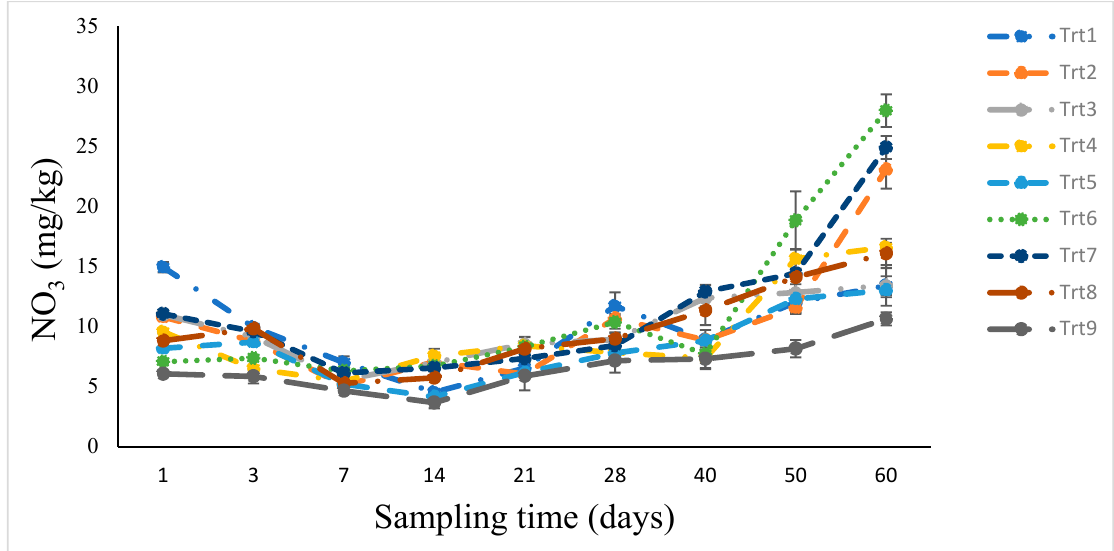
Figure 6. Nitrate released in soils during incubation at different rates of compost application. Key: Table 1. 3:1 − IMO at 5 t ha − 1 , Trt2: 3:1 − IMO at 10 t ha − 1 , Trt3: 1:2 − IMO at 5 t ha − 1 , Trt4: 1:2 − IMO at 10 t ha − 1 , Trt5 3:1 + IMO at 5 t ha − 1 , Trt6: 3:1 + IMO at 10 t ha − 1 , Trt7: 1:2 + IMO at 10 t ha − 1 , Trt9: Control.